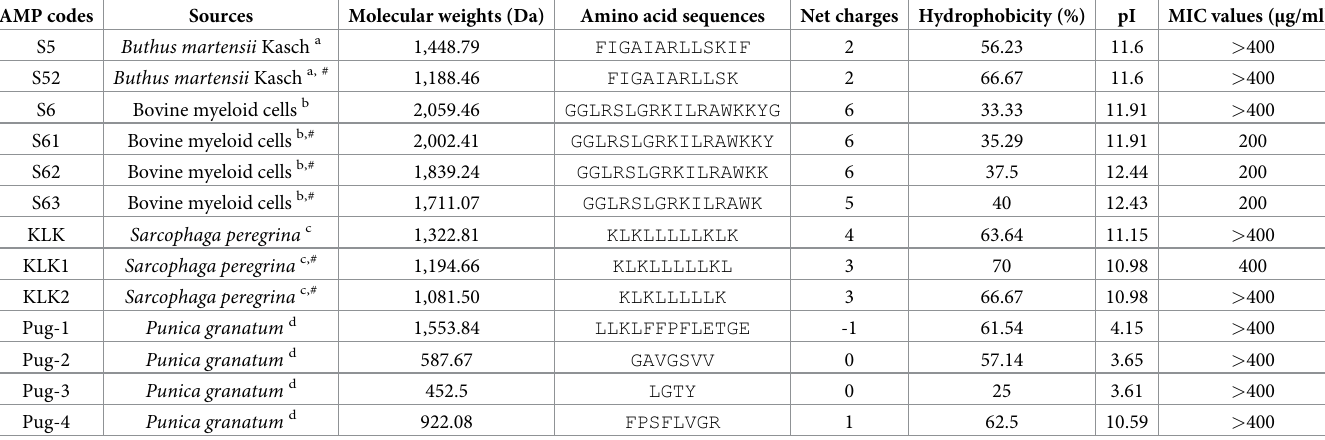
Table 1. Characteristics and properties of antimicrobial peptides used in this study. AMP